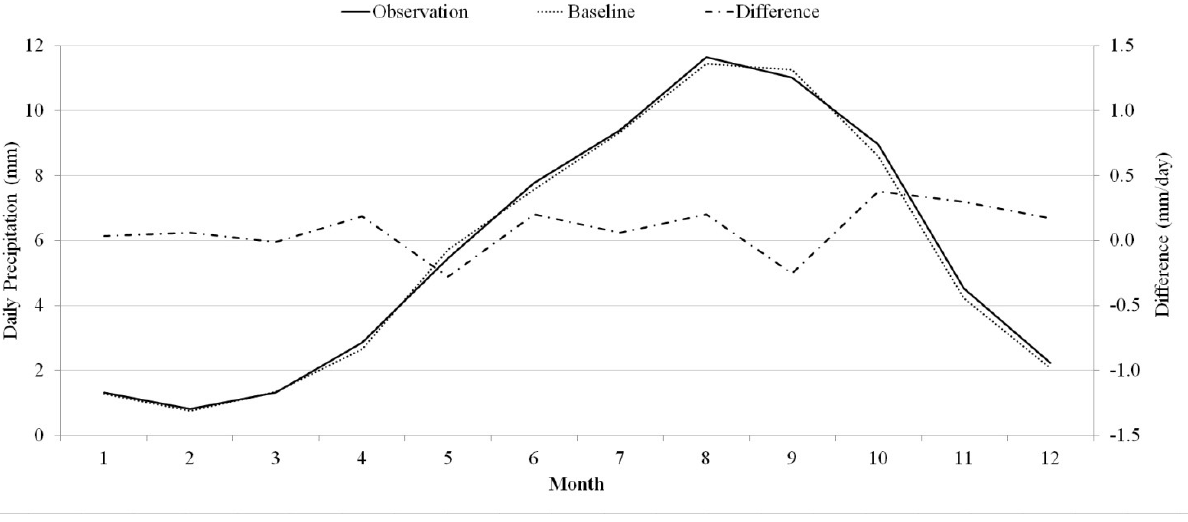
Figure 6. Average daily precipitation in 12 months from observed data (solid line–left scale) and baseline data (dotted line–left scale). The dashed line represents the differences between the two datasets (right